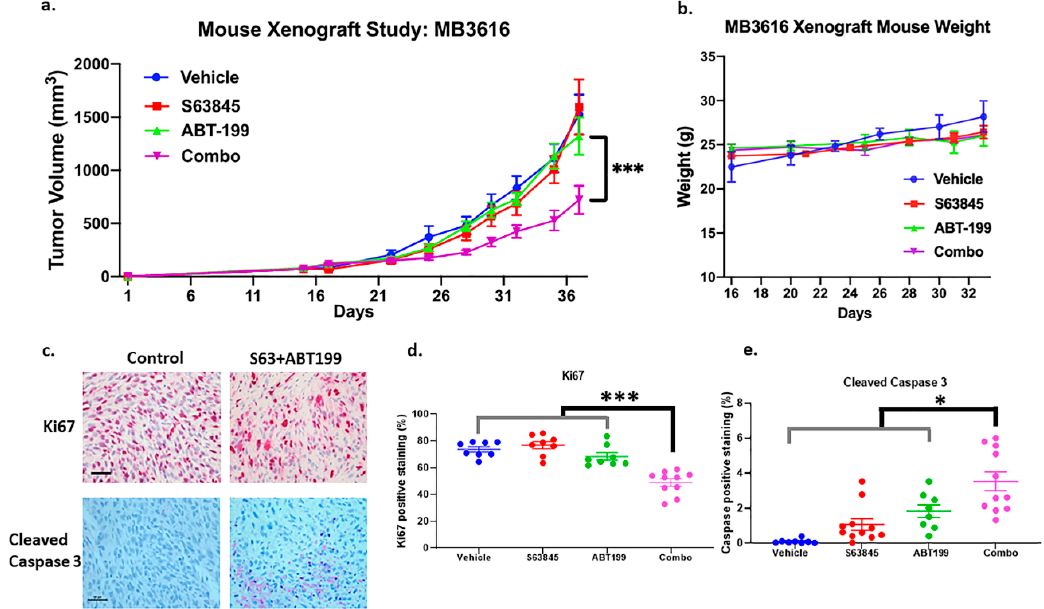
Figure 3. The treatment of ABT-199 plus S63845 significantly inhibited tumor growth without affecting mouse weight. A BRAF-WT line, MB3616, was used in the xenograft study, and tumor volume ( a ) and weight of the mice ( b ) were measured. The combination’s inhibiting effects on tumor volume was statistically significant, compared to vehicle or the single drugs ( p < 0.001) (a). ( c ) Shows representative bright-field images of Ki67 and Cleaved Caspase 3 staining from tumor sections derived from mouse xenografts experiments. Scale bar, 50 μ m. The summary quantifications are in ( d ) for Ki67 and ( e ) for cleaved Caspase 3 positive area. The effects of the combination were statically significant, compared to vehicle or individual treatments, and we only show the least significant p value of the comparisons. * indicates p < 0.05; *** indicates p < 0.001. Error bars represent +/ − SEM.